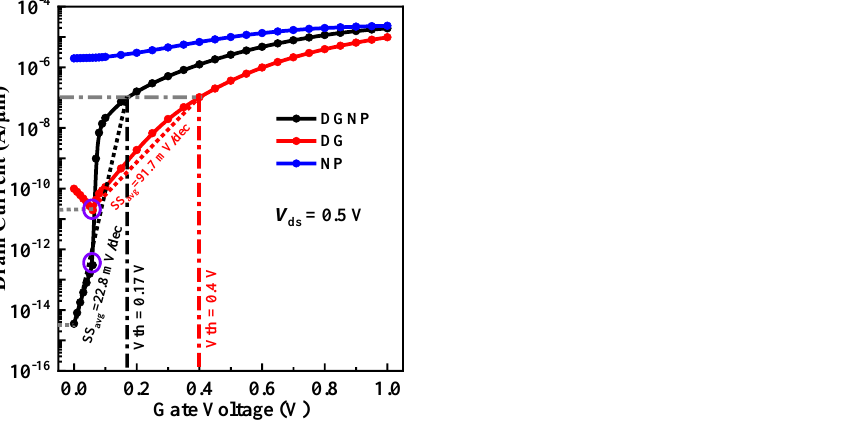
Figure 4. Transfer characteristics of DG-EHBTFET, NP-EHBTFET, and DGNP-EHBTFET.